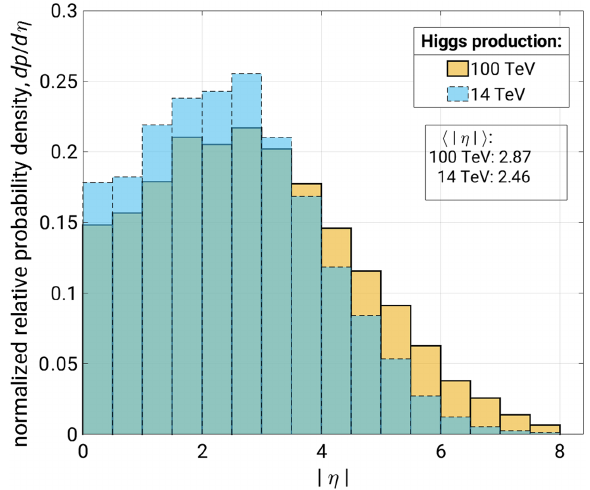
FIG. 36. Distribution of pseudorapidity for H → γγ at 14 and 100 TeV. Mean values of j η j are also